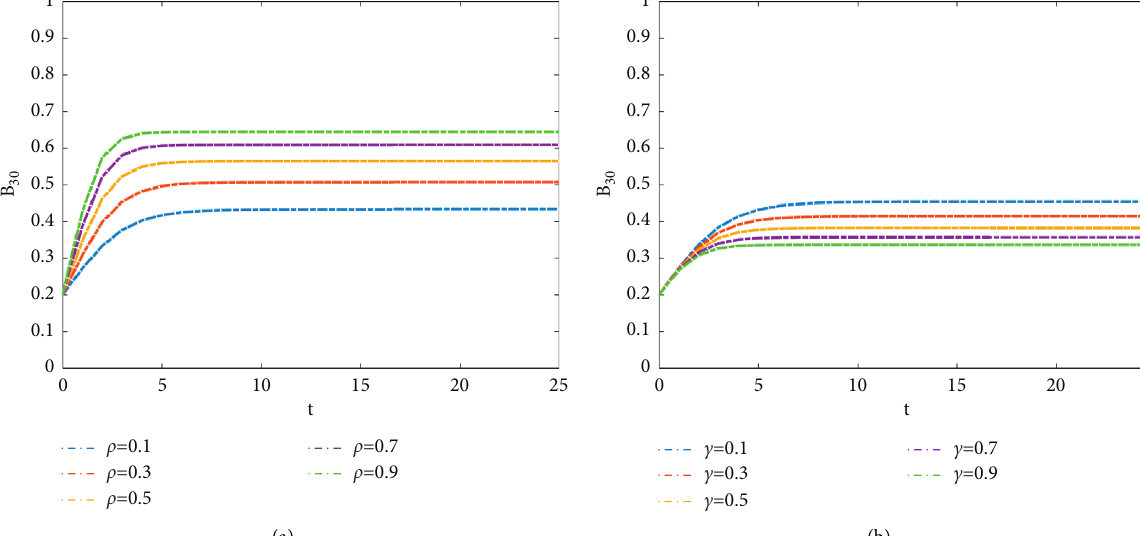
Figure 7: (a) Expected probability of buying for node 30 under θ and without control θ node 30 under θ poc